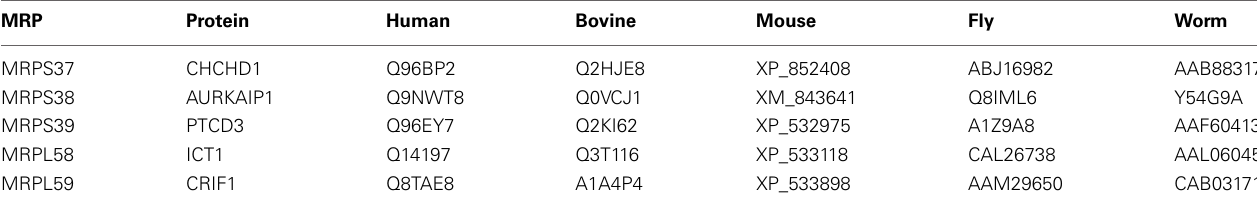
Table 3 | GenBank™ and Swiss-Prot accession numbers of new mitochondrial ribosomal proteins found in various species. MRP Protein Human